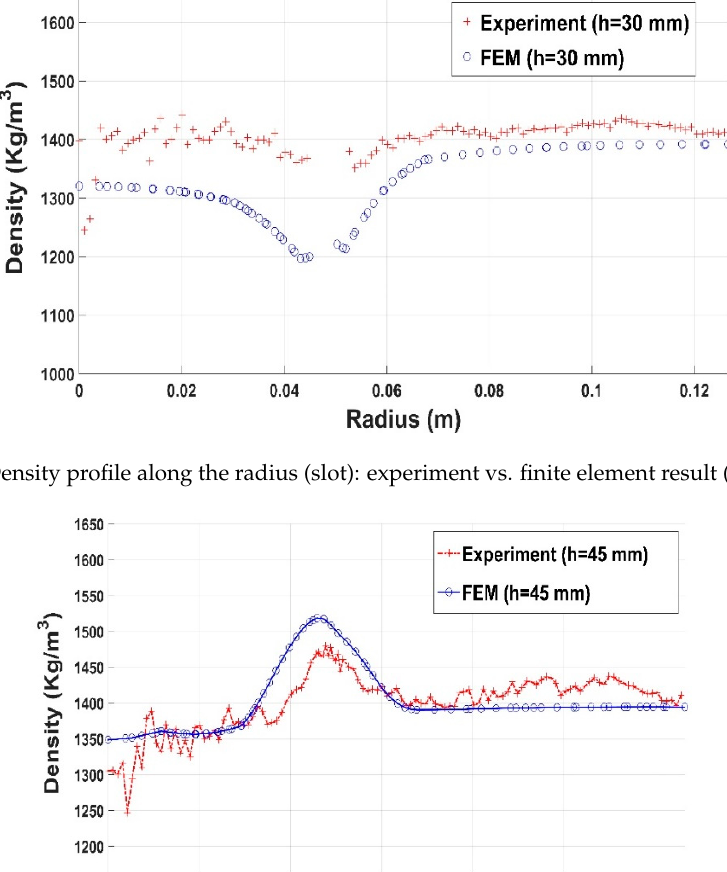
Figure 29. Layers used to compare numerical and experimental results for the slot geometry.